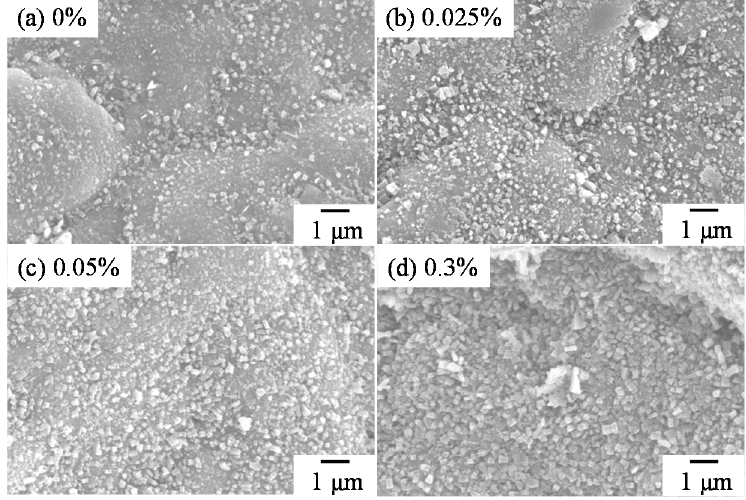
Figure 3. SEM images of surfaces of M10- x Cr-973 K/3 h samples. ( a ) 0%; ( b ) 0.025%; ( c ) 0.05%; ( d ) 0.3%.